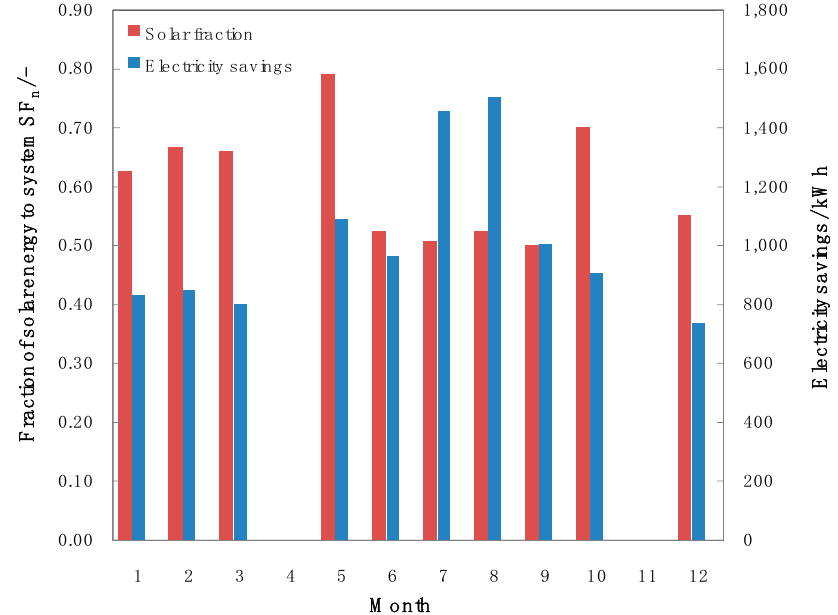
Figure 17. The monthly solar fraction SF n and electricity savings in 2018.